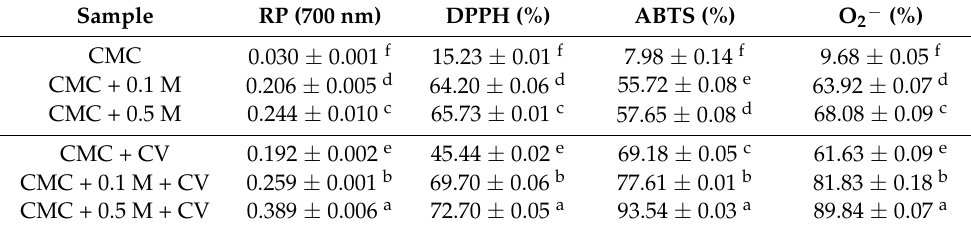
Table 1. Reducing power (RP) and radicals scavenging activity of CMC-based films.